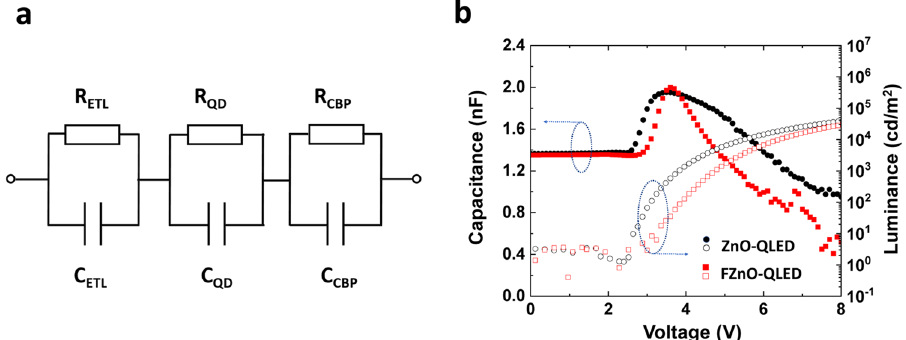
Fig. 6 a The equivalent circuit model used for the C-V analysis. b C-V-L characteristics of the